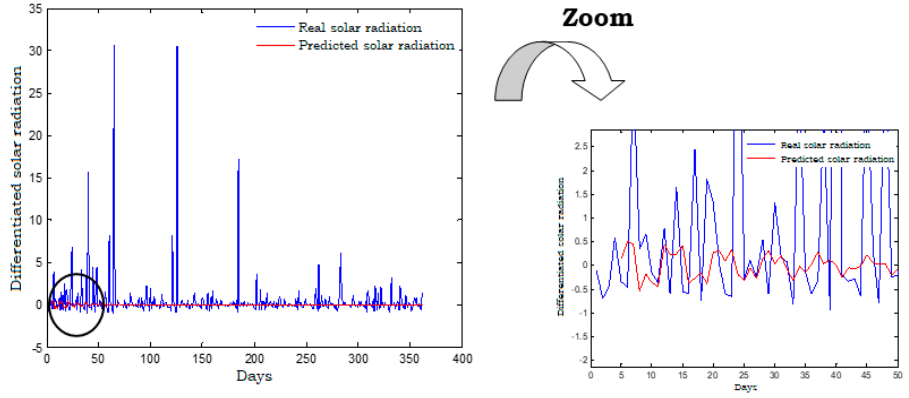
Figure 18. Solar radiation prediction using the ARMA (4,4) model.